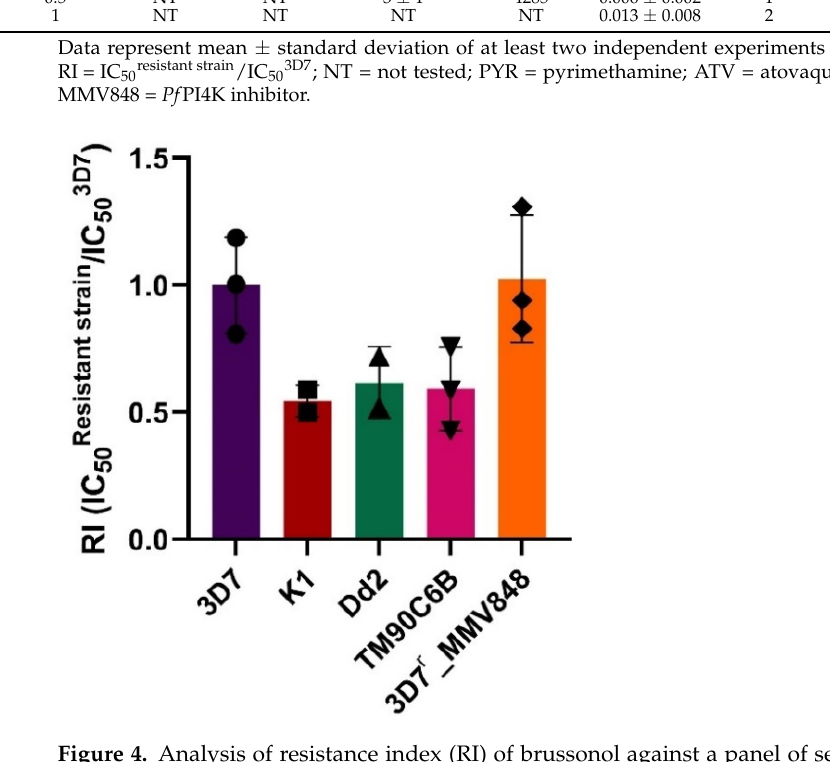
Figure 4. Analysis of resistance index (RI) of brussonol against a panel of sensitive and resistant P. falciparum strains (K1, Dd2, TM90C6B, and 3D7 r _MMV848) relative to the sensitive strain (3D7). Plot of the fold-change in the antiplasmodial potency of brussonol against a panel of resistant strains relative to the sensitive strain. ( n ≥ 2, mean IC 50 ± SD).